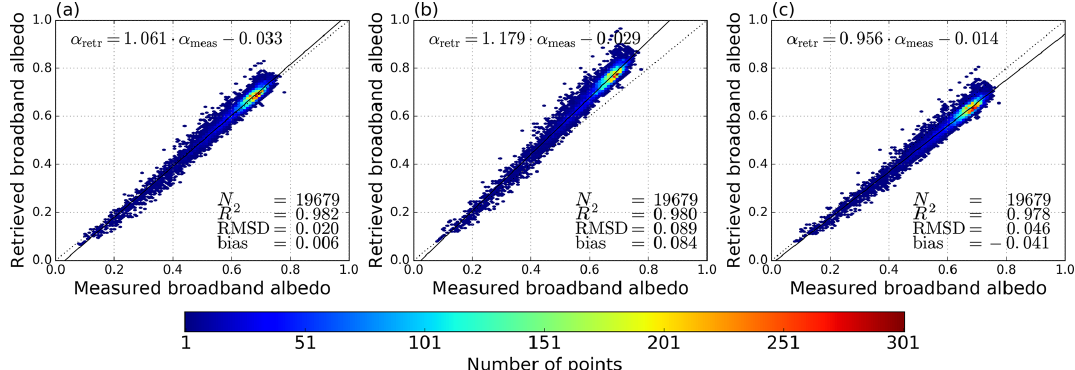
Figure 2. Scatterplot of measured broadband albedo and retrieved broadband albedo by applying the empirically derived STBC method (a) , the conversion method of Istomina et al. (2015) (b) , or the conversion method by Gao et al. (2004) (c) to measured spectral albedo. Mea- surements were done by the Polar 5 aircraft over sea-ice floes on 25 June 2017. Colors indicate the number density of points. The solid and dotted lines indicate the regression and one-to-one line,